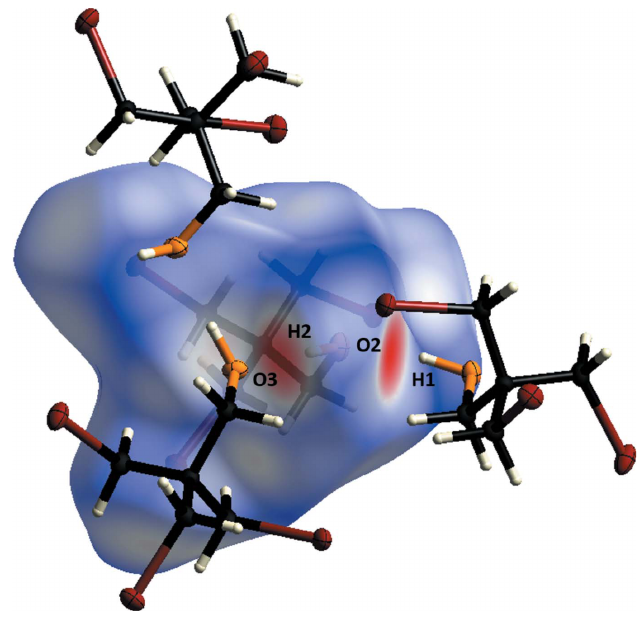
Figure 4 Hirshfeld surface analysis of 1 showing close contacts in the crystal. The